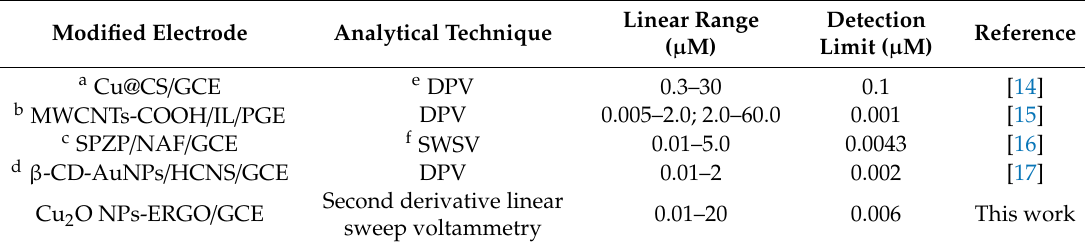
Table 1. Comparison of different modified electrodes for RhB.